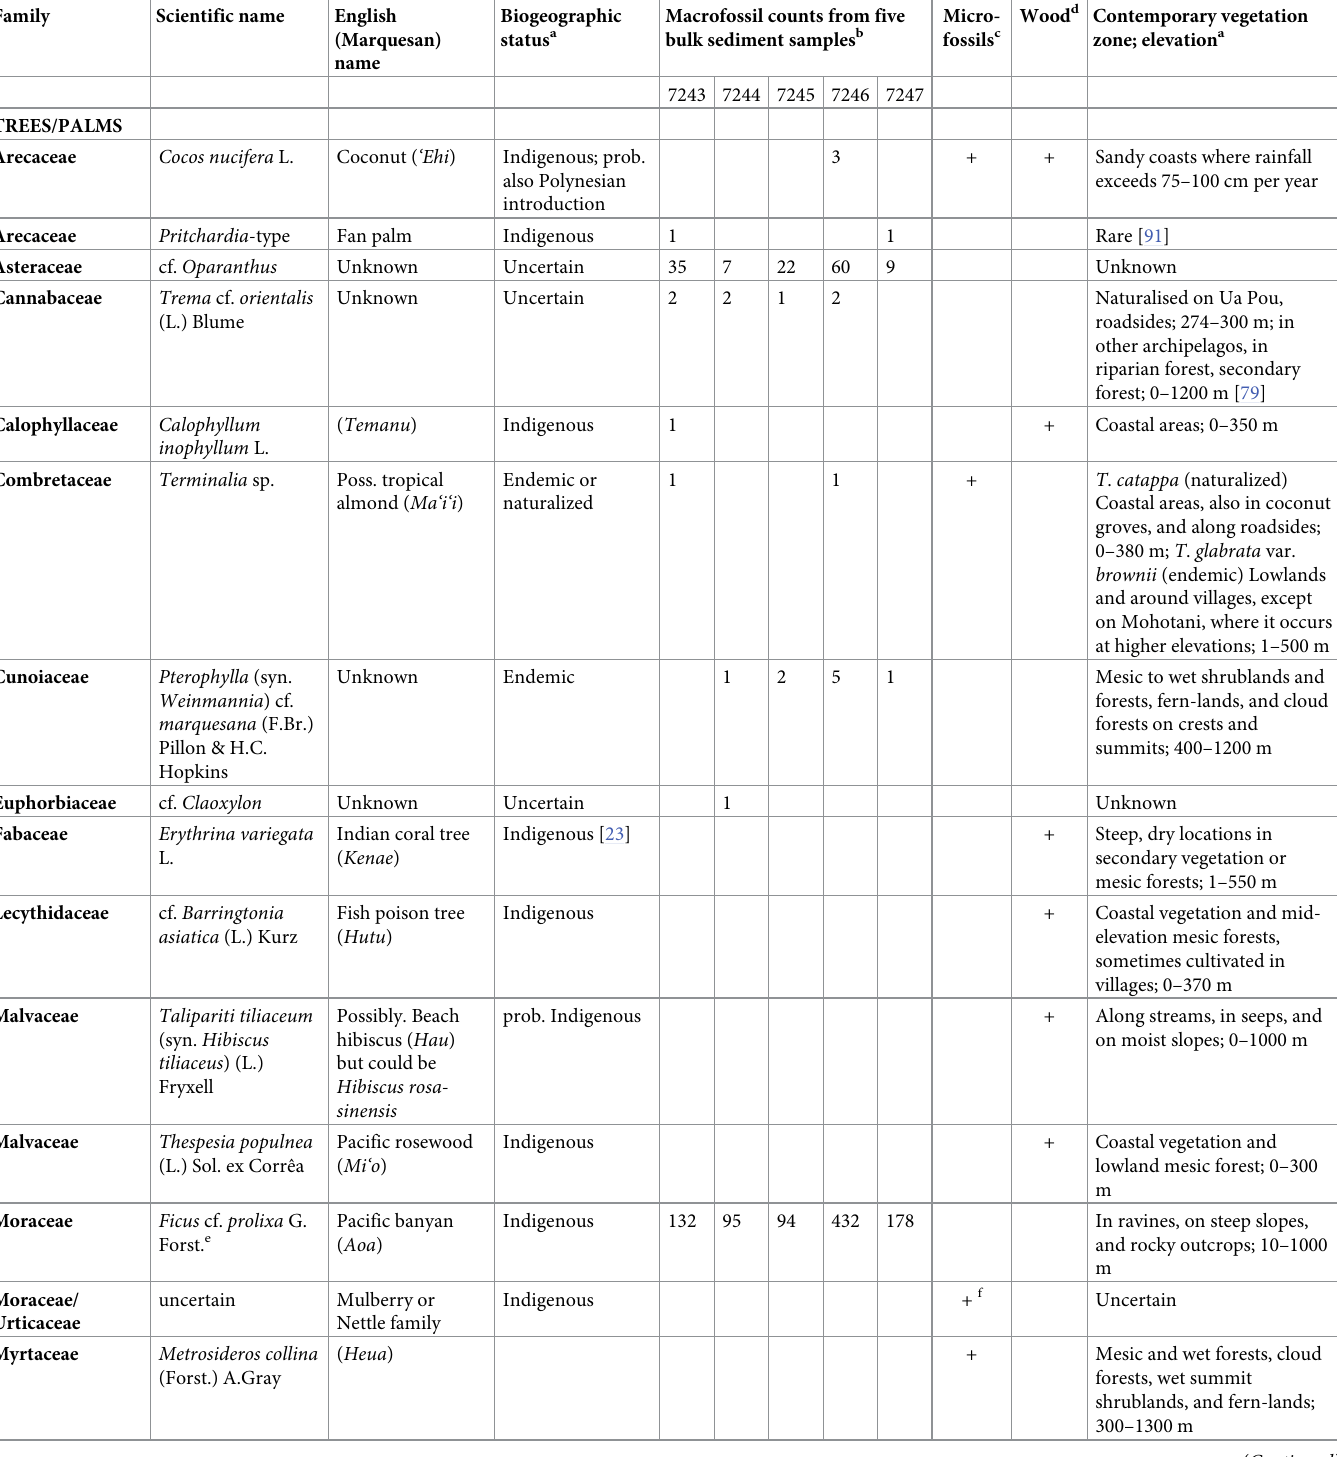
Table 3. Summary of identified plant material (+ = present).